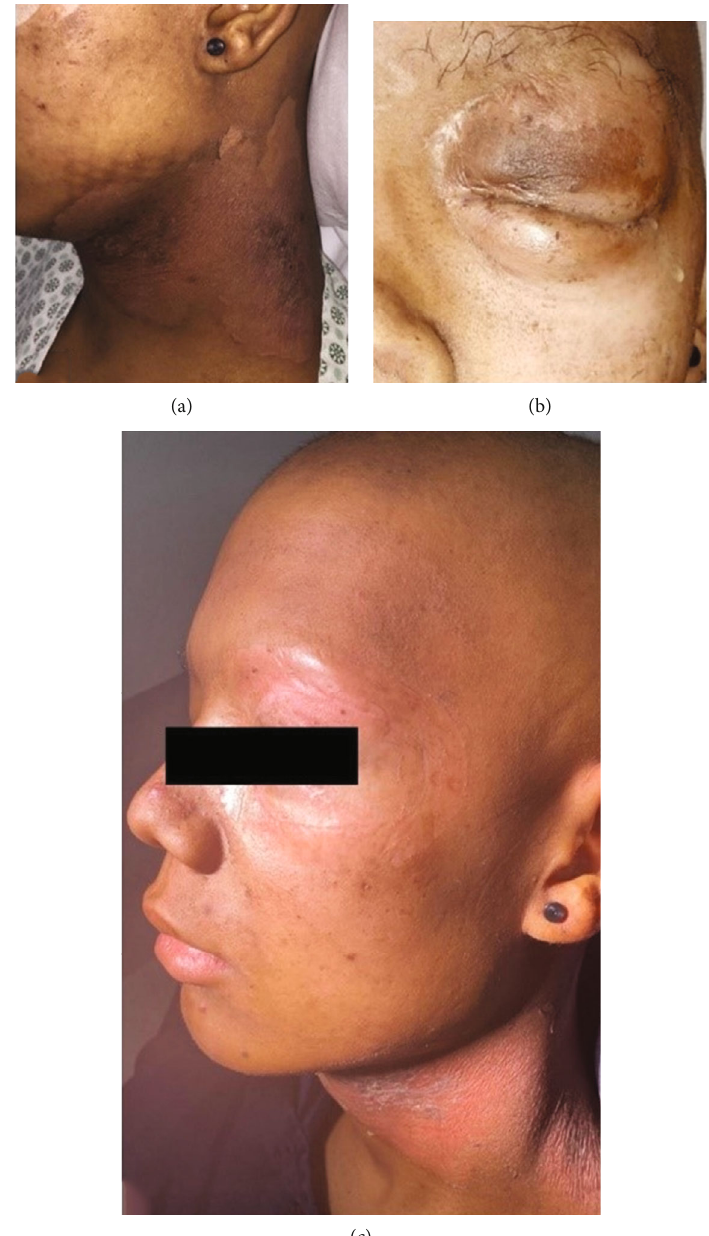
Figure 5: Extraoral manifestations after RT. Dermatological changes induced by radiation (a) in the periorbital region (b) and local alopecia (b, c). (c) Clinical appearance after local use of ointments and moisturizing